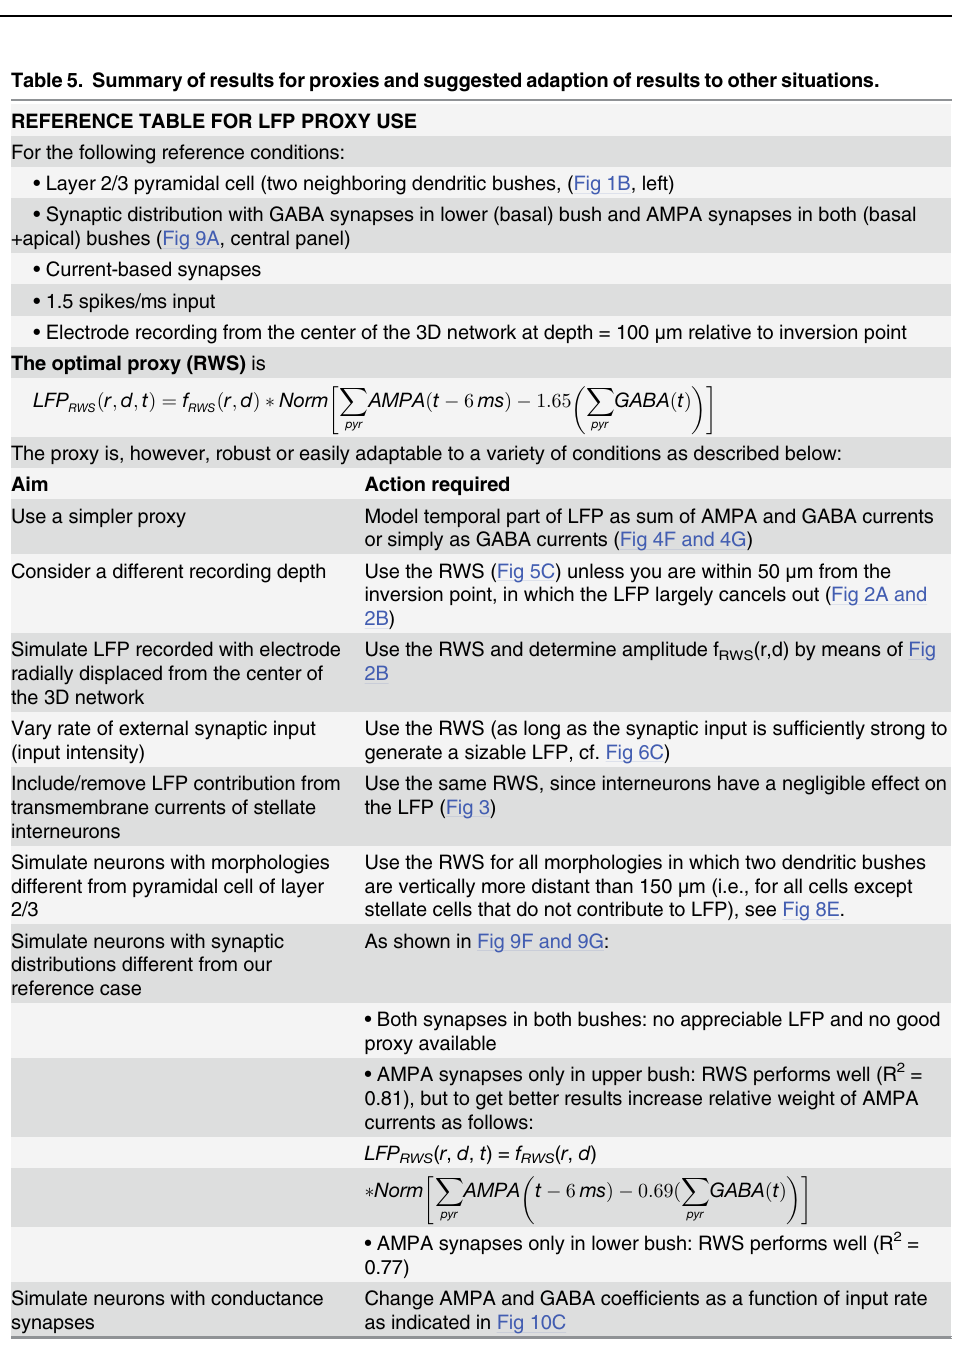
Table 5. Summary of results for proxies and suggested adaption of results to other situations. REFERENCE TABLE FOR LFP PROXY